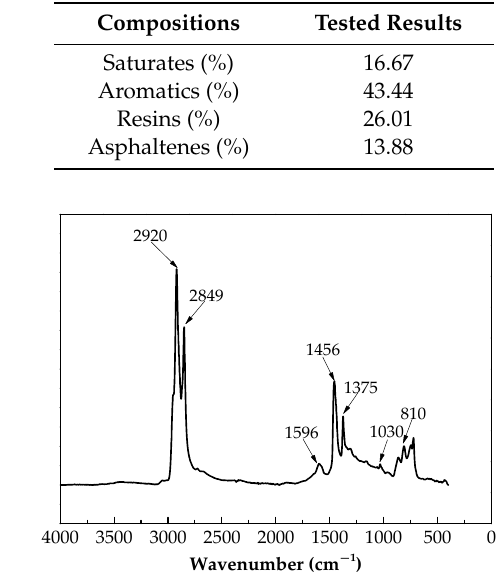
Figure 1. FTIR spectrum of the base asphalt.